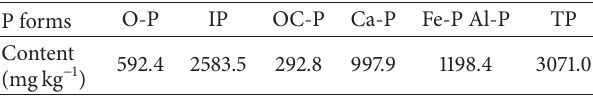
Table 2: Various forms of P and their content distributions.